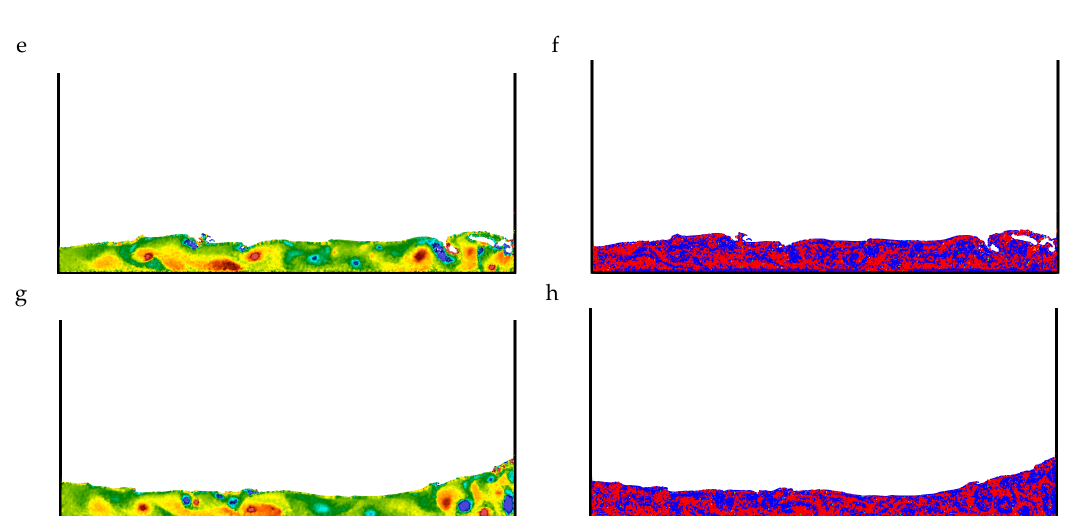
(cid:112) g / H = 13.02, figures ( e , f )